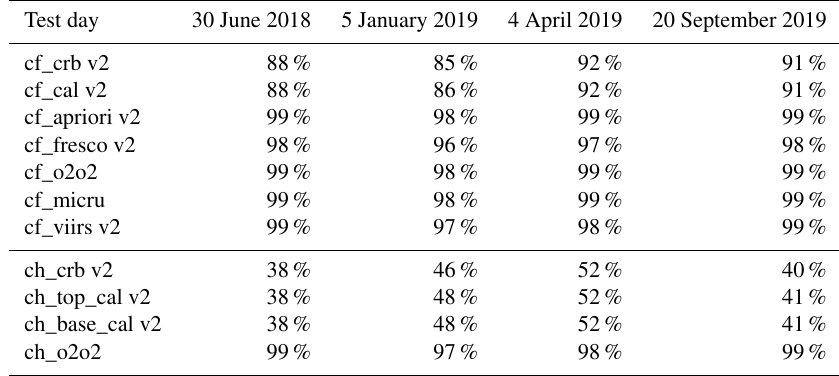
Table B2. As Table B1 but in the region of